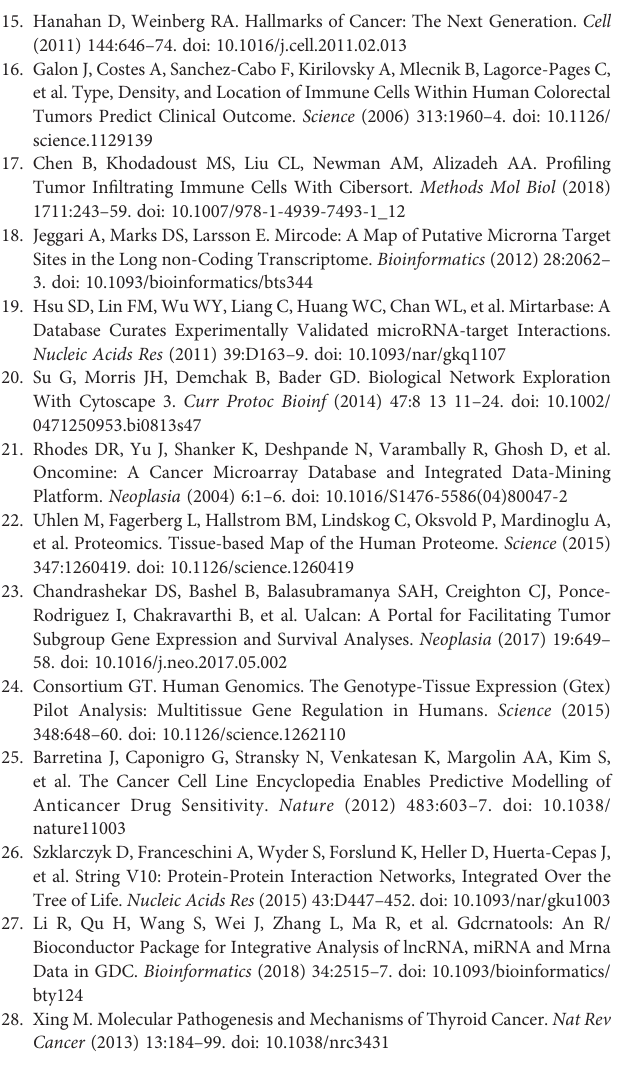
Supplementary Figure 2 | Forty-two genes were signi fi cant in the Kaplan-Meier analysis. Supplementary Figure 3 | The expression of ALPL and CD11c in the follicular (A-D) and medullary (E-H) thyroid carcinoma. The ALPL and CD11c was higher in thyroid carcinoma tissues (A, C, E, G) compared to the paracancerous tissue specimens (B, D, F, H) . Supplementary Figure 4 | ALPL and CD11c ( ITGAX ) expression in the Oncomine database. Supplementary Figure 5 | ALPL and CD11c( ITGAX ) expression. (A, B) UALCAN database; (C, D) GTEx Portal database. Supplementary Figure 6 | ALPL and ITGAX expression. (A – C) CCLE database; (D, E) STRING database; (F – M) Human Protein Atlas database; (F, G) ALPL was not detected in thyroid carcinoma tissue; (H, I) ALPL had medium expression in normal thyroid tissue; (J, K) CD11c had high expression in thyroid carcinoma tissue; (L, M) CD11c was not detected in normal thyroid